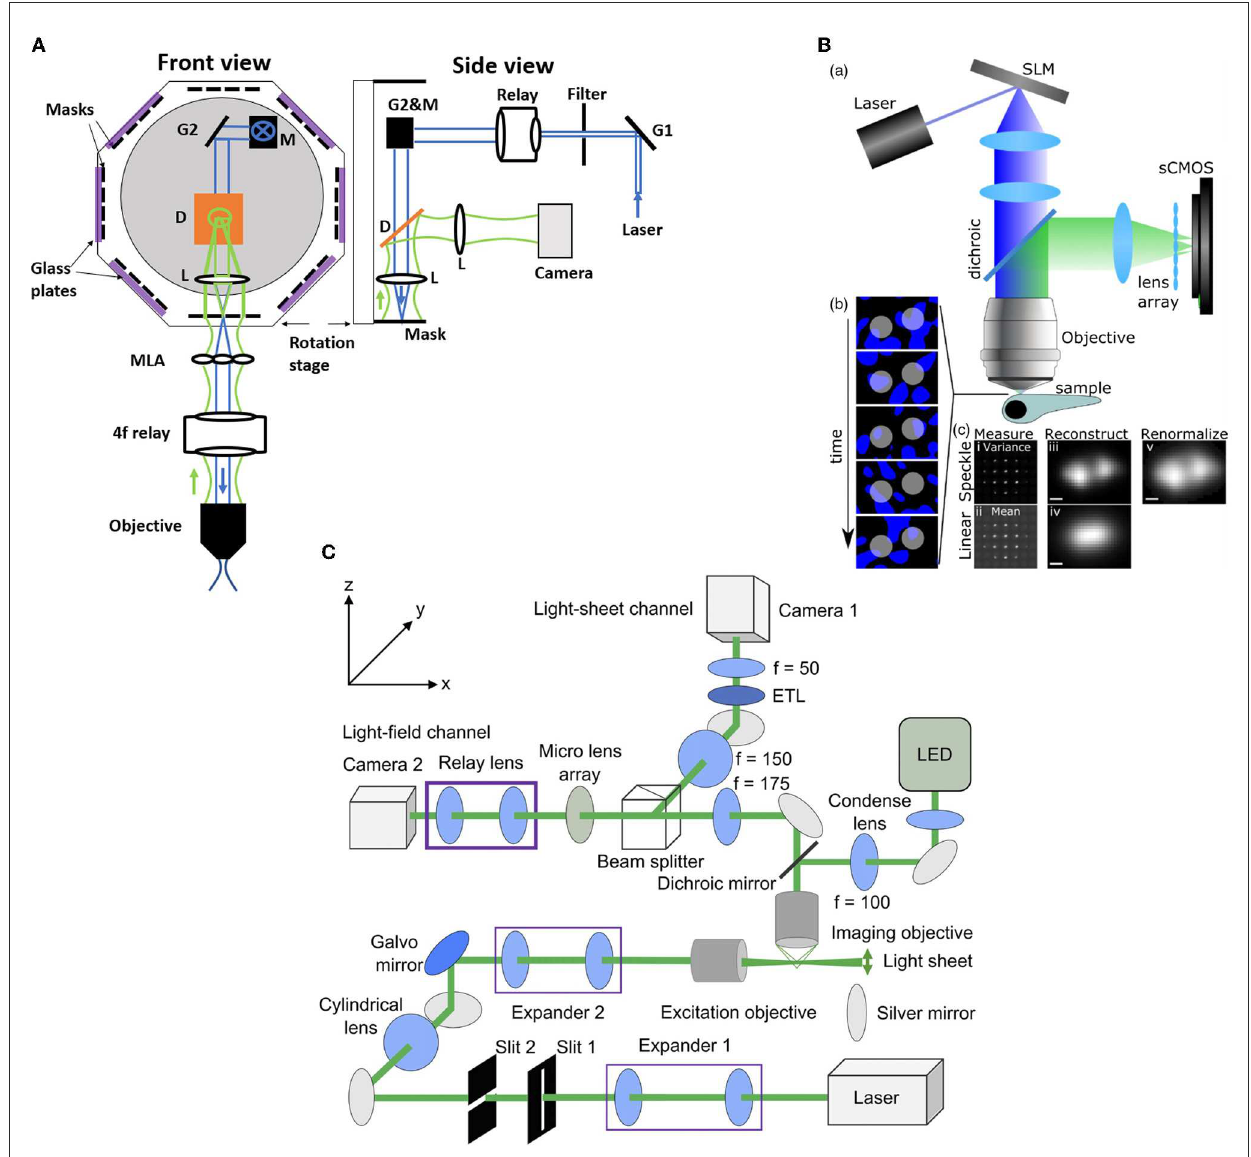
FIGURE5 Hybrid LFM systems. (A) Confocal LFM (Zhang et al., 2021a), front and side views. G: scanning galvo mirror; Relay: achromatic relay lens system; M: mirror; D: dichroic mirror; L: achromatic lens. The mask is placed on a rotational stage. (B) Structured light LFM (Taylor et al., 2018). Top, speckle-based LFM utilizes controlled speckle illumination by imaging an SLM pattern with a random phase mask onto the objective back focal plane. Bottom left, fluorescent beads are illuminated with random speckle patterns displayed into the SLM and the resulting light is recorded. Bottom right, comparison of the speckle, top, and linear, bottom, LFM by taking the variance and the mean of the recorded data. The middle picture shows the differences in the PSF measurements. The beads are resolved in the speckle LFM while unresolved in the linear LFM. Scale bar 2 µ m (C) Light-sheet LFM (Wang et al., 2019): Simultaneous imaging by light-sheet and light-field modalities. On the right, a zoomed-in view of the detection paths is shown. (B) reproduced with permission from Taylor et al. (2018), (C) reproduced with permission from Wang et al. (2019) ©The Optical